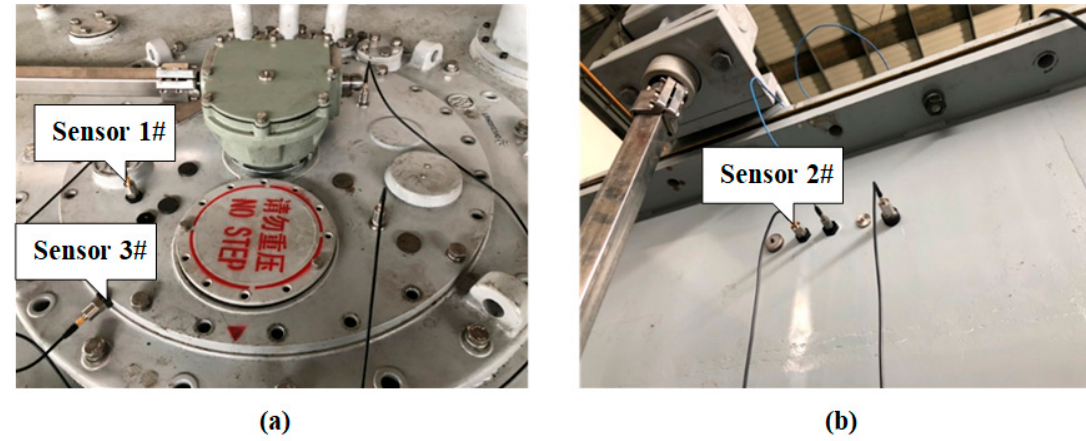
Figure 1. Installation location of the vibration acceleration sensors.